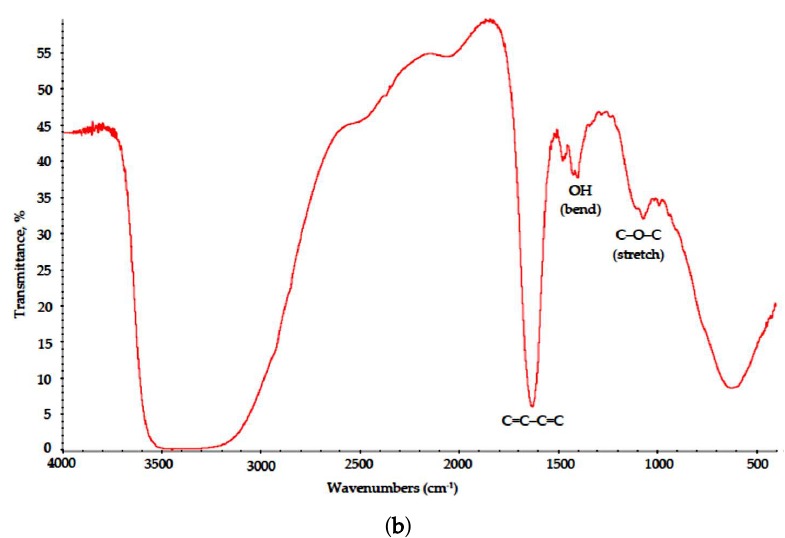
Figure 7. IR spectra of the (a) Na-CMC–CAY and (b) Na-CMC–MAY powders.